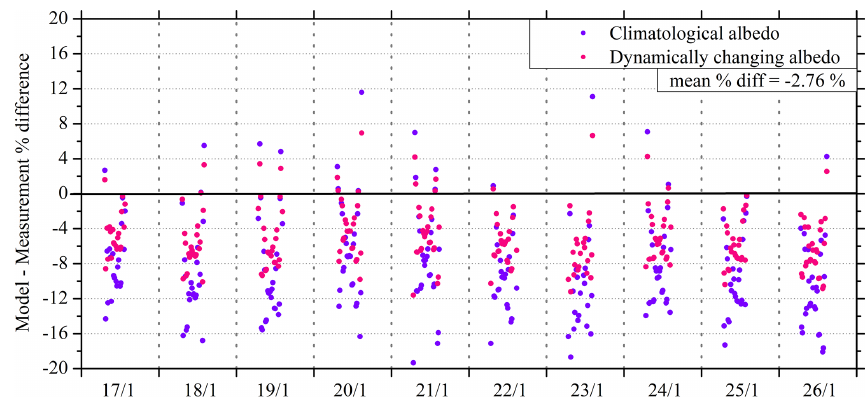
Figure 11. The effect of surface albedo correction on UVI for the Davos station. The climatological and dynamically changing albedo in terms of percentage differences of modeled and ground measurements during a snow-covered period (17–26 January) under clear-sky